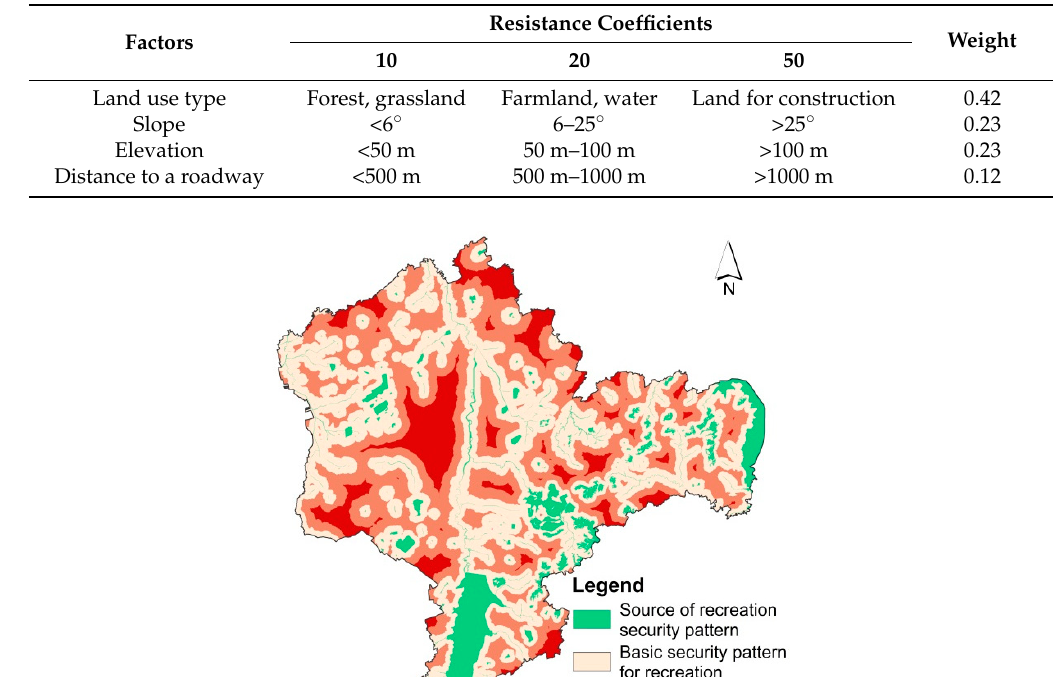
Table 4. Resistance coefficients and weights of resistance factors for recreation activities.